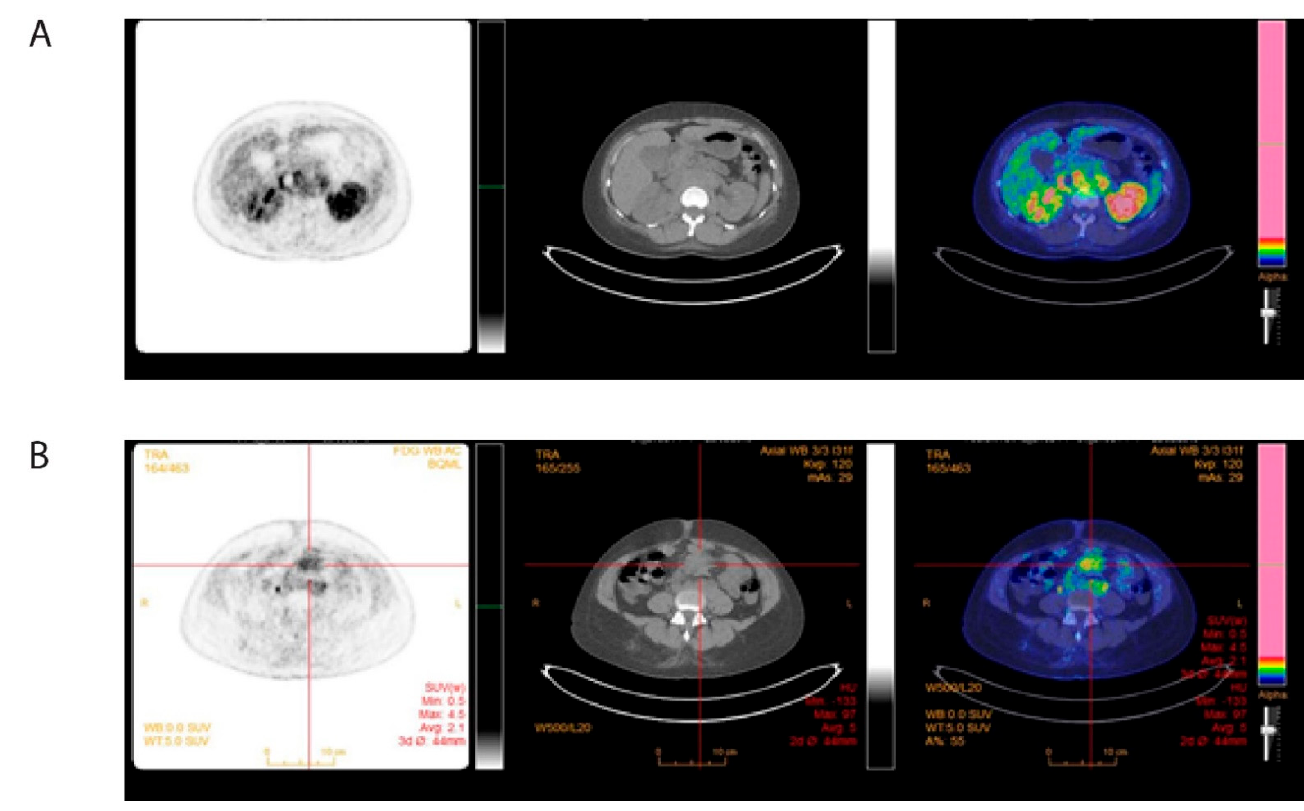
Figure 3. Pretreatment 18-fluorodeoxyglucose (FDG) positron emission tomography (PET)-computed tomography (CT) of abdomen. ( A ) [ 18 F]-FDG-PET/CT at diagnosis showing FDG-positive para-aortic ( B ) and mesenteric tumor masses.